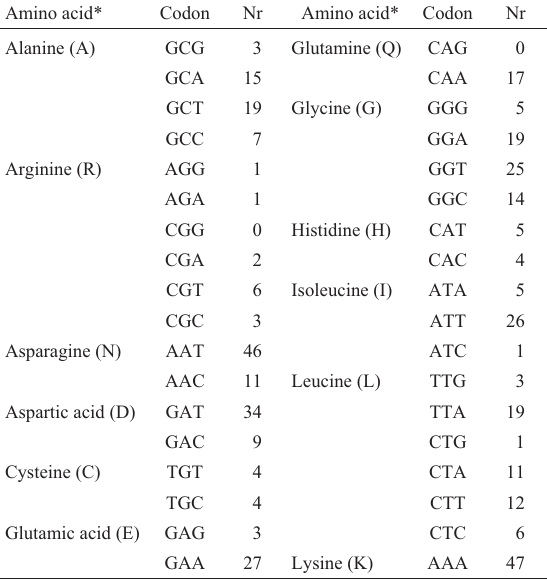
Table 1 - Amino acid codons for the Bacillus thuringiensis serovar sotto ( Bt sotto ) Schi gene. Amino acid*